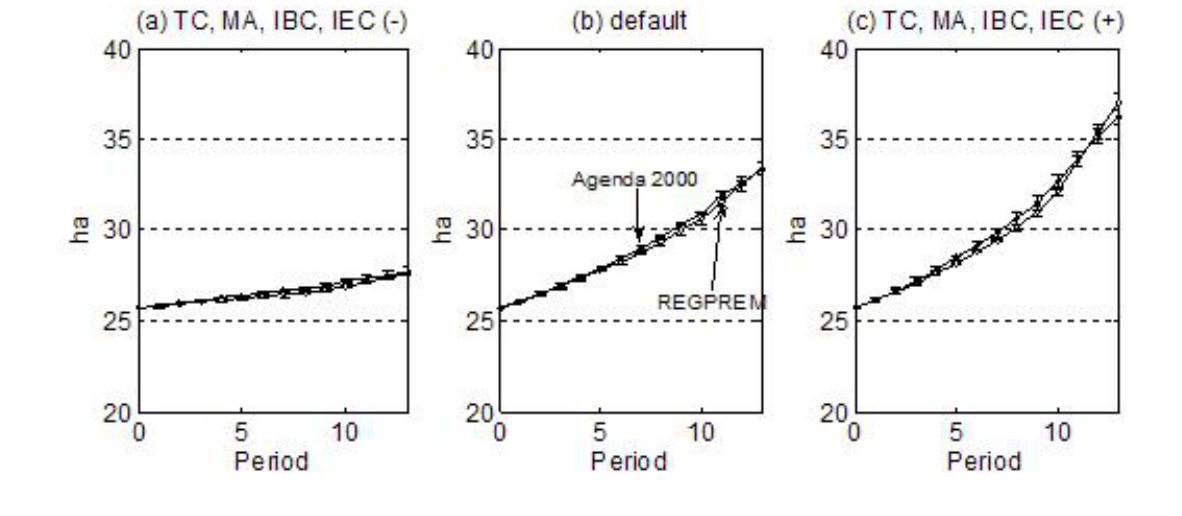
Fig. 5. Evolution of average farm size over 14 simulation periods and two policies, i.e., Agenda 2000 and the decoupled policy (REGPREM) for low factor levels (-), default, and high factor levels (+). Averages of five replications and standard errors. IBC, is interest on borrowed capital, IEC, interest on equity capital, MA, cost savings due to managerial ability, and TC, for technological